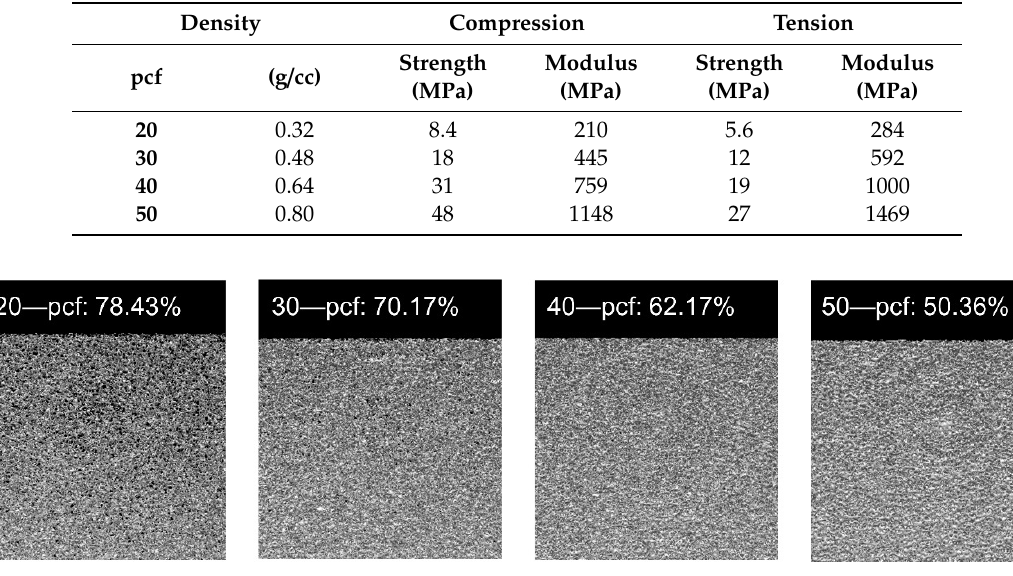
Figure 2. Porosity of the polyurethane foam blocks with different densities.